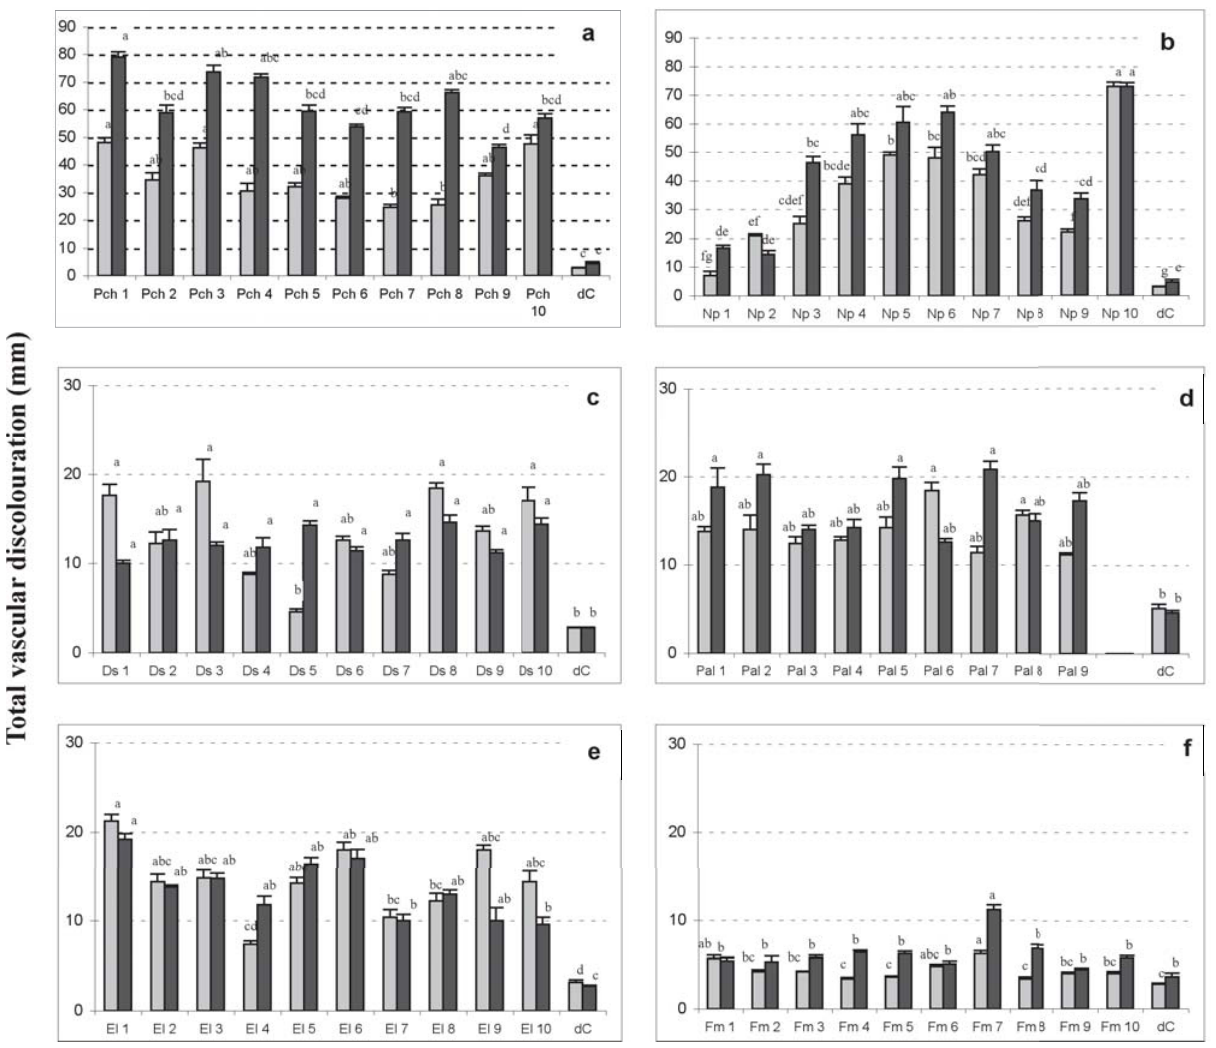
Fig. 2. Aggressiveness of the isolates of the six species tested in seedlings of cv. Cabernet Sauvignon compared to drilled control (dC): a, Phaeomoniella chlamydospora (Pch). b, Neofusiccocum parvum (Np). c, Diplodia seriata (Ds). d, Phaeoacremonium aleophilum (Pal). e, Eutypa lata (El). f, Fomitiporia mediterranea (Fm). Total vascular discol- ouration was the sum of the upward and downward lesions. Mean lesion length was based on fi ve replicate isolates at each date ( ¢ 5 months after inoculation - ¢ 15 months after inoculation). Means followed by different letters are signi fi cantly ( P <0.05) different according to Newman-Keuls test. Bars symbolise standard error of the